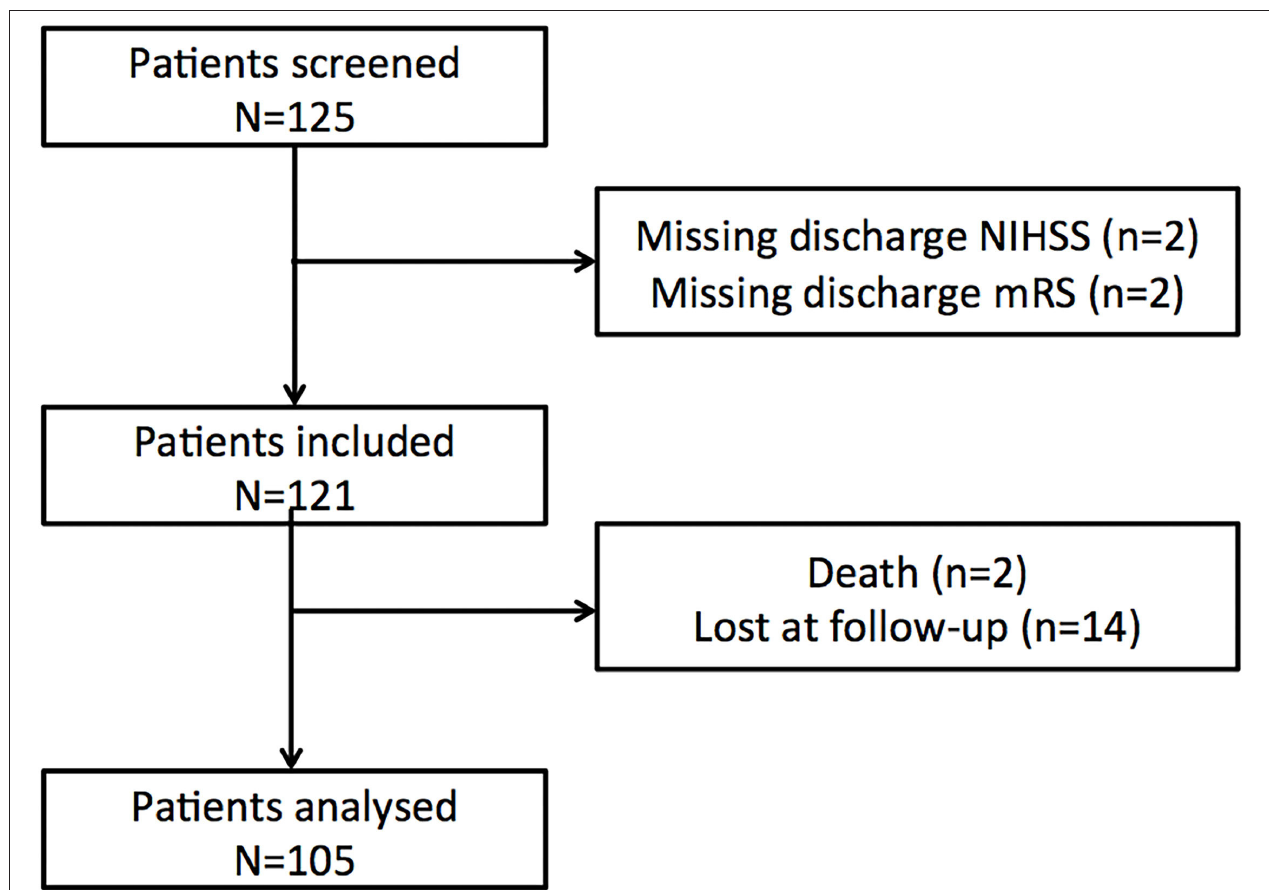
FIGURE 1 | Flowchart of the training